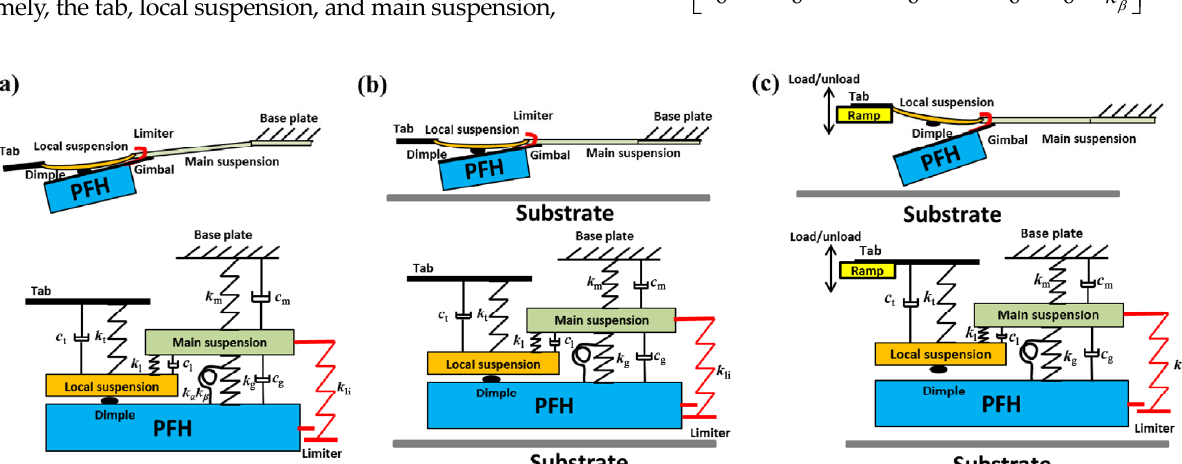
Fig. 2 Schematic of the suspension-PFH-air-substrate (SPAS) system: (a) suspension in the unloaded state, (b) dynamic motions of the head during flying with the suspension in the loaded state, and (c) load/unload